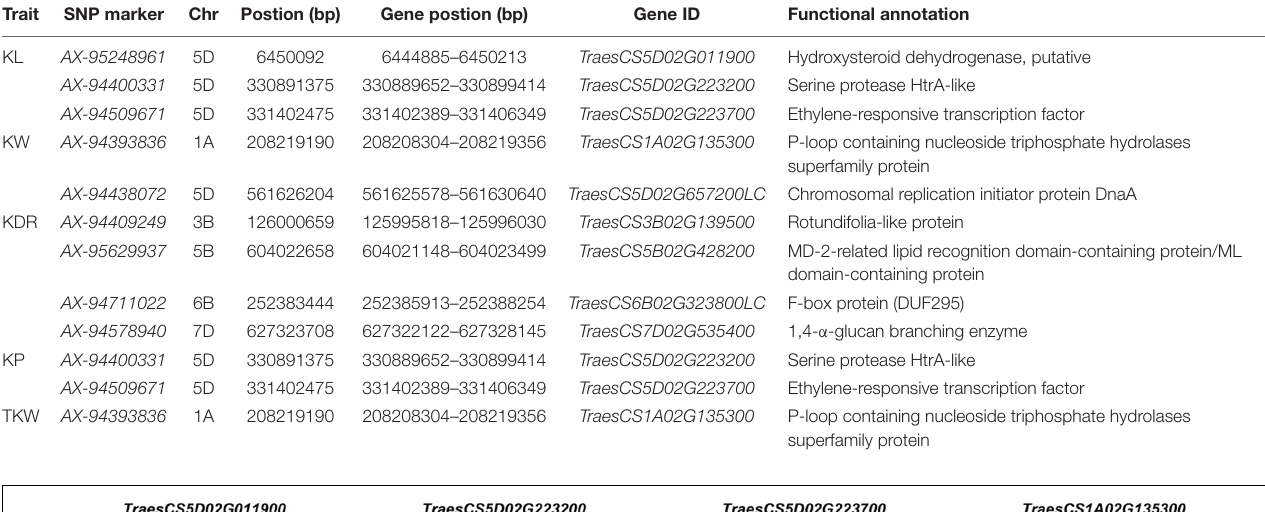
TABLE 3 | Candidate genes underlying the significant markers associated with kernel traits. Trait SNP marker Chr Postion (bp) Gene postion (bp) Gene ID Functional annotation